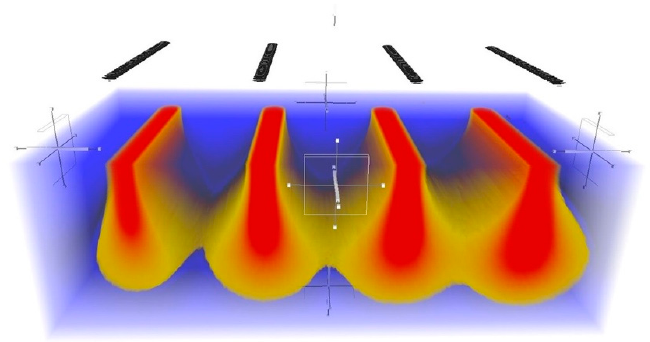
Figure 1. Damage of the silicon substrate caused by incident He-FIB in Monte Carlo simulation.